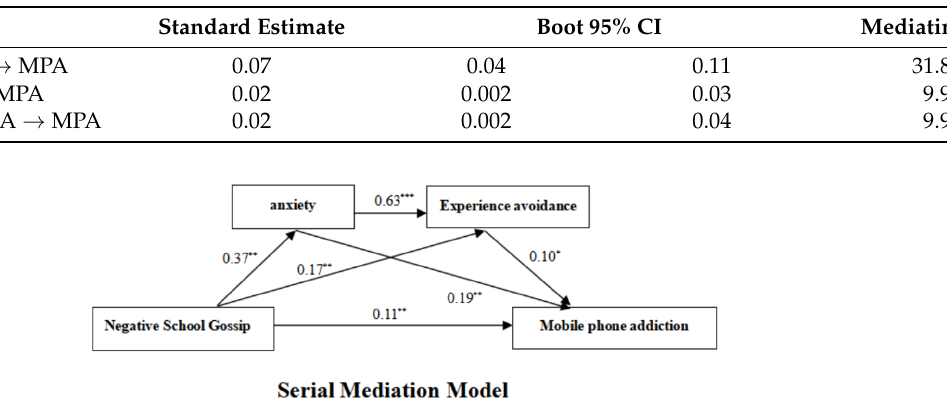
Table 3. 95% Confidence Intervals of the Mediation Effects.